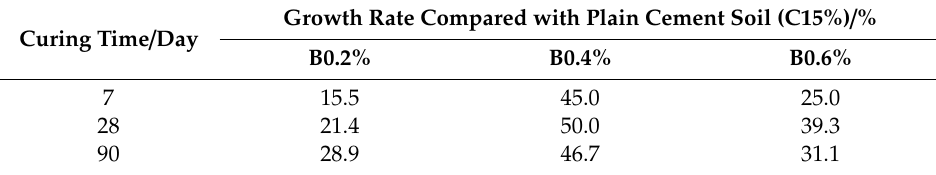
Table 5. Growth ratio of tensile strength of cement soil with different basalt fiber content. Curing Time /